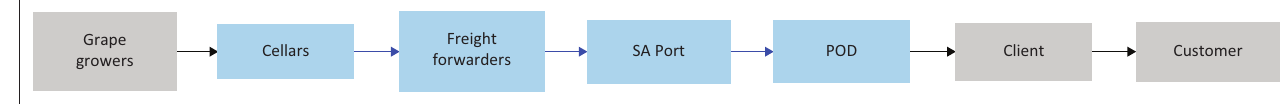
FIGURE 1: High-level representation of South Africa’s export supply